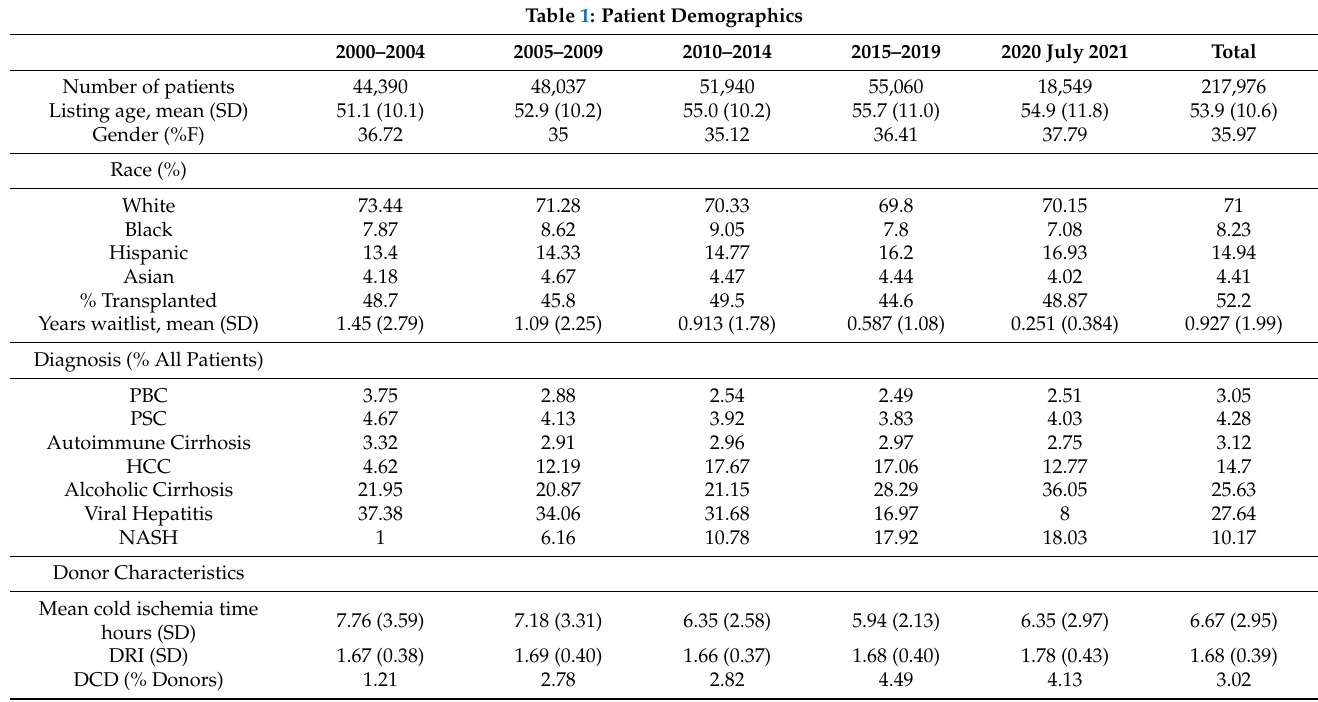
Table 1. Donor and Recipient Patient